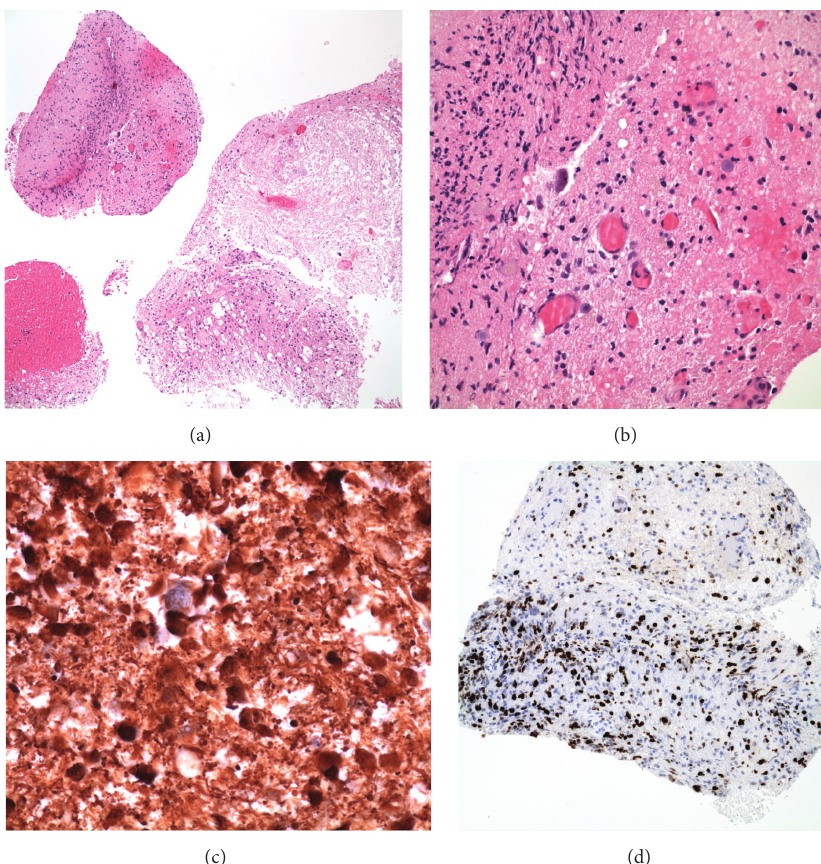
Figure 3: Histopathology of medullary tumor. (a) Multiple small fragments of the biopsy include one with significant necrosis, one with relatively high cell density, and one with considerable hemorrhage. H&E, original magnification 100x. (b) At high magnification, this portion of the biopsy shows tumor with moderate cell density bordering necrotic tumor. H&E, original magnification 400x. (c) Many of the tumor cells have cytoplasmic GFAP immunoreactivity, establishing their astrocytomatous phenotype. Original magnification 600x. (d) A Ki67 immunostain shows a proliferative index of up to about 25%, consistent with the diagnosis of a high-grade glioma. Original magnification